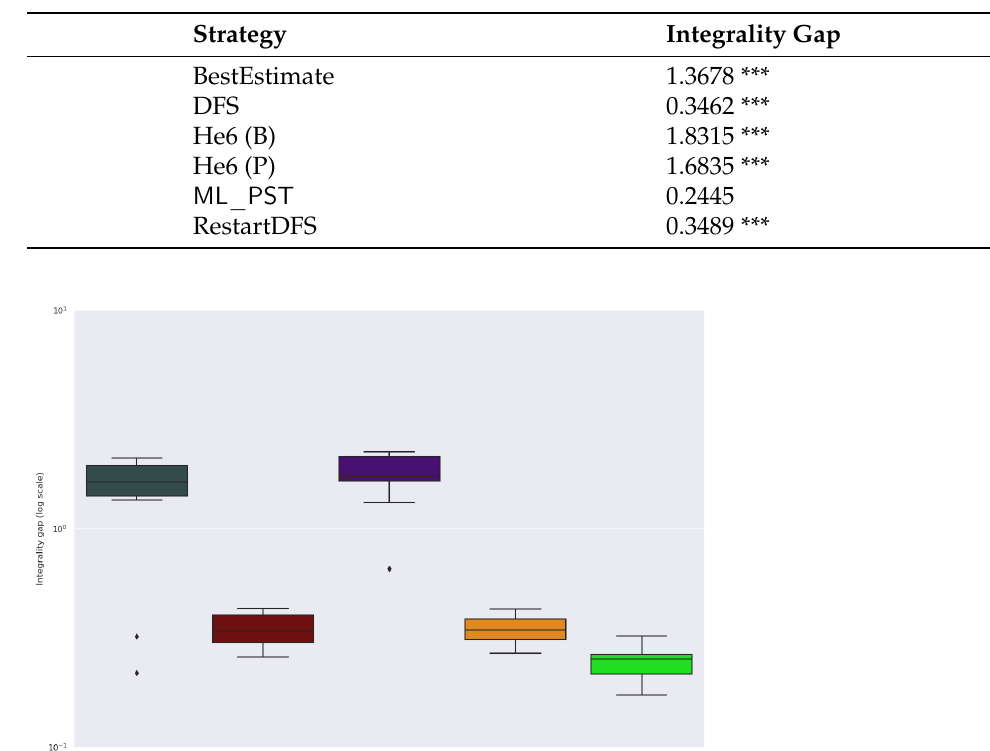
Figure 4. Hard set cover: mean solving time vs. mean integrality gap of the first solution found at a leaf node. Orange points are Pareto-efficient, blue are not. ‘**’ p < 0.01. Table 8. Hard set cover: ML model with on_both = PrioChild, on_leaf = Score and prune_on_both = True against the baselines, with equal time limits for each problem. Pairwise t -tests against the ML policy: ‘***’ p < 0.001.